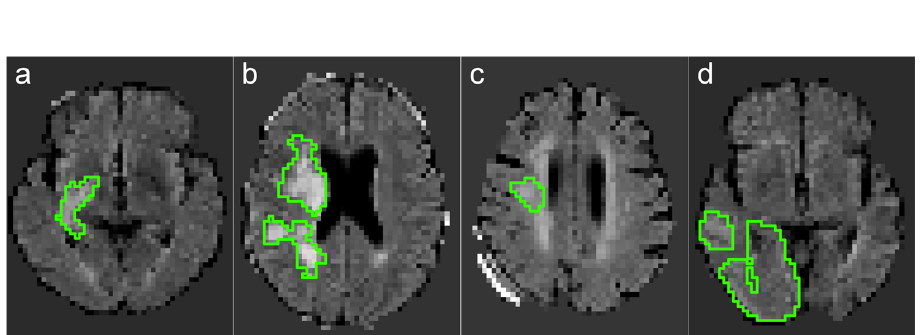
Fig 5. Cases failed by at least one classifier. (a) 09/24 ground-truth (GTG). (b) 11/29 ground-truth (GTG). (c) 39/36 ground-truth (GTG). (d) 41/24 ground-truth (GTG).